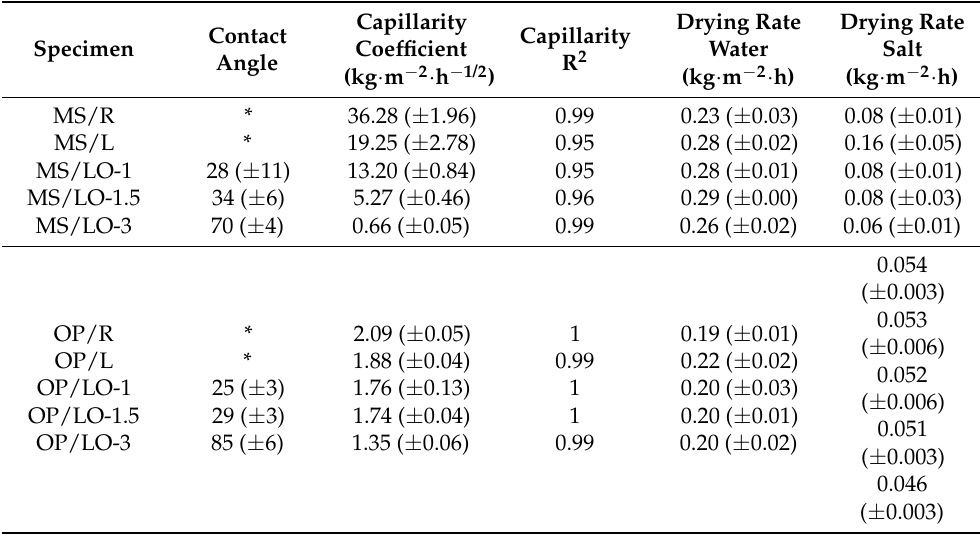
was then calculated by image analysis. Measurements were performed in four replicates for each stone and limewash type, and the results are given in Table 3. Table 3. Values of contact angle with water drops, water absorption by capillarity coefficient, drying rate, and drying index (average of 4 specimens ± standard deviation).